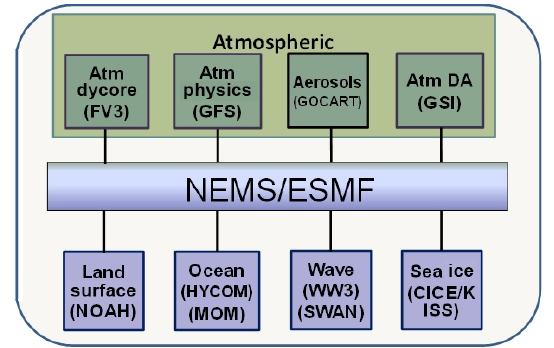
Figure 8. Next Generation of Global Prediction System (NGGPS) implementation